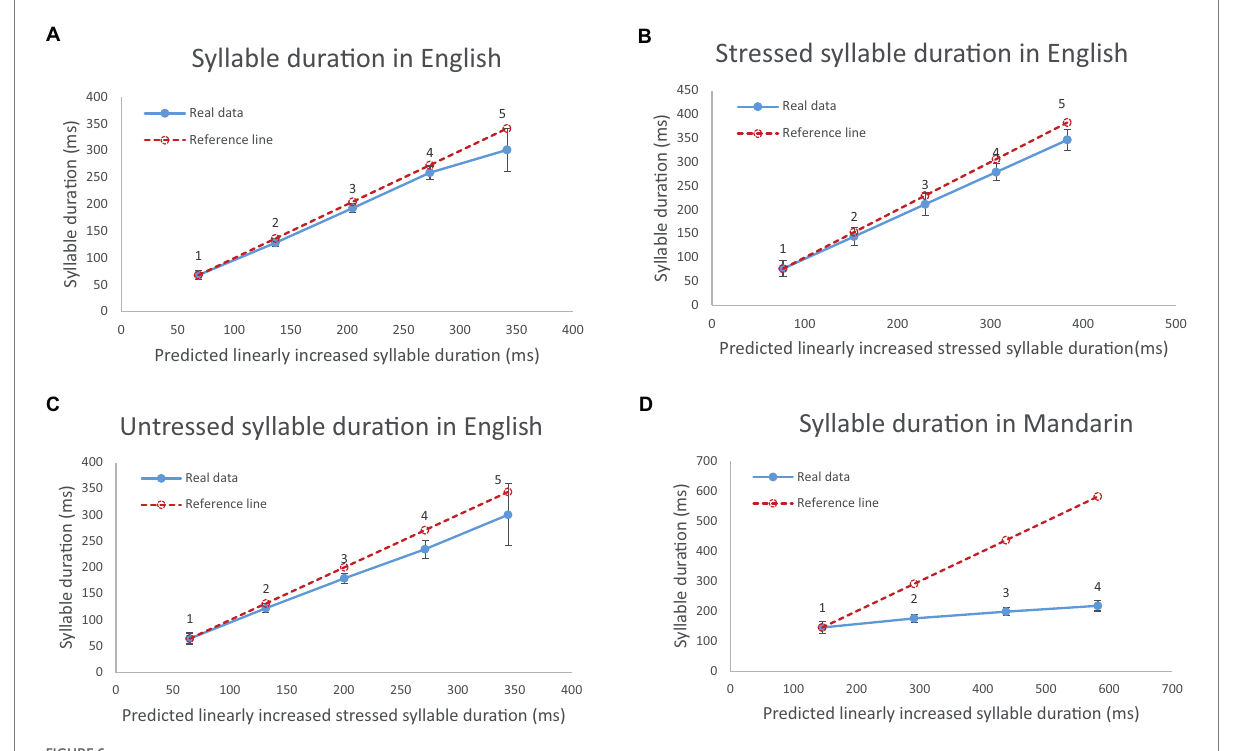
FIGURE 6 Mean syllable duration in English and Mandarin as a function of syllable size (number of component segments) for all English syllables (A) , English stressed syllables (B) English unstressed syllables (C) and Mandarin syllables (D) . In each plot the dashed line is the reference line consisting of points each with the same increment as the duration of monosyllabic words (leftmost point). The number of syllables is indicated by a number above each point in the